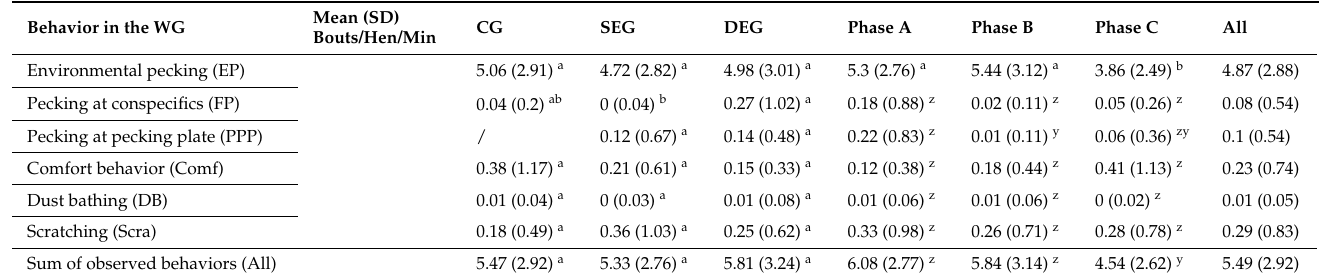
Table 5. Mean and standard deviation (SD) of the different behaviors per minute and hen observed in the WG of three groups (CG = control group, SEG = single enrichment group, DEG = double enrichment group) and different phases during production (Phase A: peak of laying period, weeks of life (LWs) 31/32; Phase B: middle of laying period, LWs 50/51; Phase C: end of laying period, LWs 64/65/71).